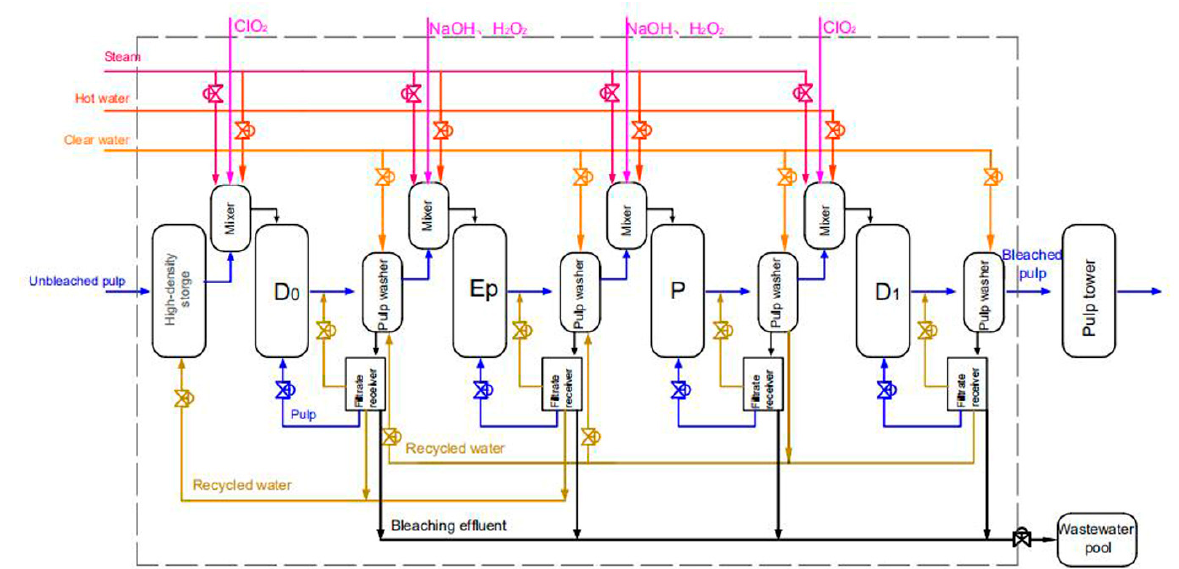
Figure 1. Schematic diagram of a typical bleaching system (D 0 EpPD 1 ).